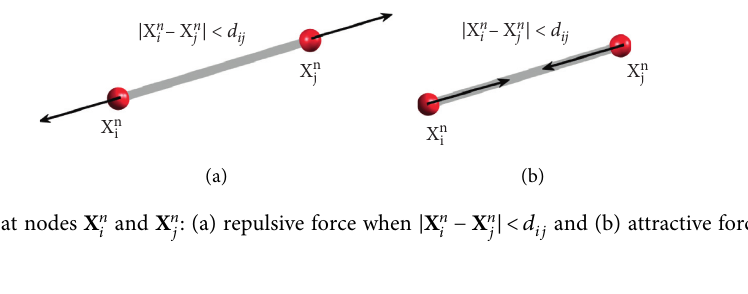
Figure 1: Illustration of distance function d ) /ln ( min W )) . q � − ( ln ( D max